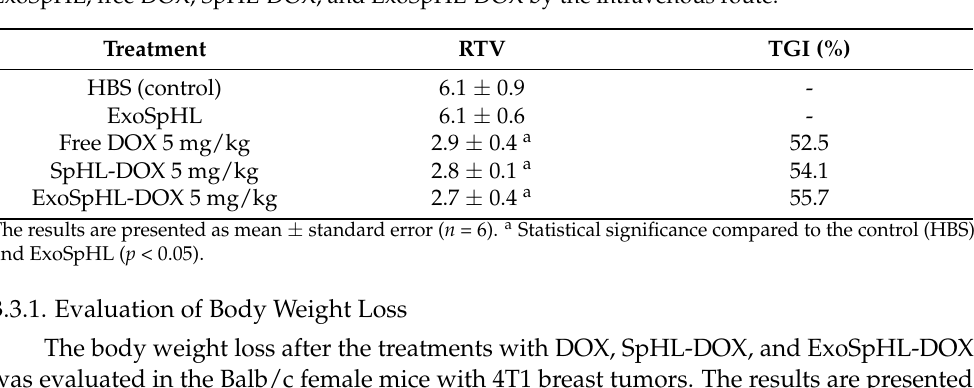
Figure 4. Antitumor efficacy evaluation of female Balb/c mice with 4T1 breast tumors. ( A ) Variation in the mice breast cancer tumor volume after treatment with HBS, ExoSpHL, DOX, SpHL-DOX, and ExoSpHL-DOX. Every 2 days, the animals intravenously received five administrations of HBS (control), ExoSpHL, or DOX at a cumulative dose of 25 mg/kg, SpHL-DOX at a cumulative dose of 25 mg/kg, or ExoSpHL-DOX at a cumulative dose of 25 mg/kg. ( B ) Percentage of body weight variation on day 10 after the administration of HBS (control), ExoSpHL, or DOX at a cumulative dose of 25 mg/kg, SpHL-DOX at a cumulative dose of 25 mg/kg, or ExoSpHL-DOX at a cumulative dose of 25 mg/kg. All data are presented as mean ± SEM, n = 6. a Statistical significance compared to the control group (HBS) and ExoSpHL ( p < 0.05). Abbreviations: HBS: HEPES buffered saline; ExoSpHL: tumor-derived exosomes fused with long-circulating and pH-sensitive liposomes; DOX: doxorubicin; SpHL-DOX: long-circulating and pH-sensitive liposomes containing doxorubicin; ExoSpHL-DOX: tumor-derived exosomes fused with long-circulating and pH-sensitive liposomes containing doxorubicin; SEM: standard error of the mean. Table 3. Relative tumor volume and tumor growth inhibition after the administration of HBS, ExoSpHL, free DOX, SpHL-DOX, and ExoSpHL-DOX by the intravenous